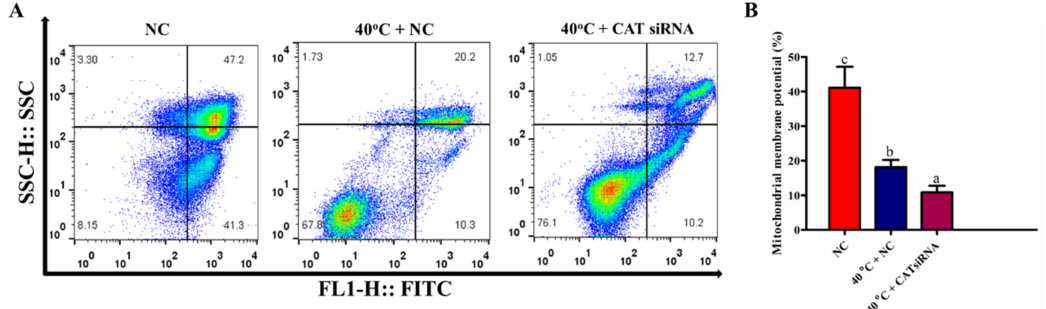
Figure 7. CAT regulates MMP of GCs under HS. Flow cytometric analysis for MMP of cultured GCs from the NC and treated (40 ◦ C + NC and 40 ◦ C + CAT si RNA) groups ( A , B ). Values are expressed as mean ± SEM of n = 3. Superscripts (a, b, c) represent a significant ( p < 0.05) di ff